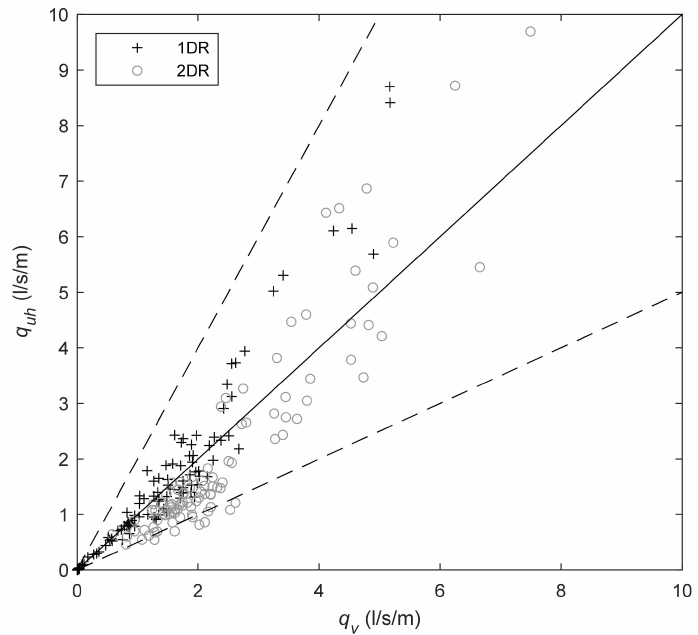
Figure 4. Scatter plot comparing the overtopping discharge measured using the peak volume ( q v ) and sum of positive discharge methods ( q uh ) for all 20 min segments during 1DR (black crosses) and 2DR (grey circles). The solid black line represents q v = q uh and the black dashed lines indicate a factor of 2 range about the 1:1 line.